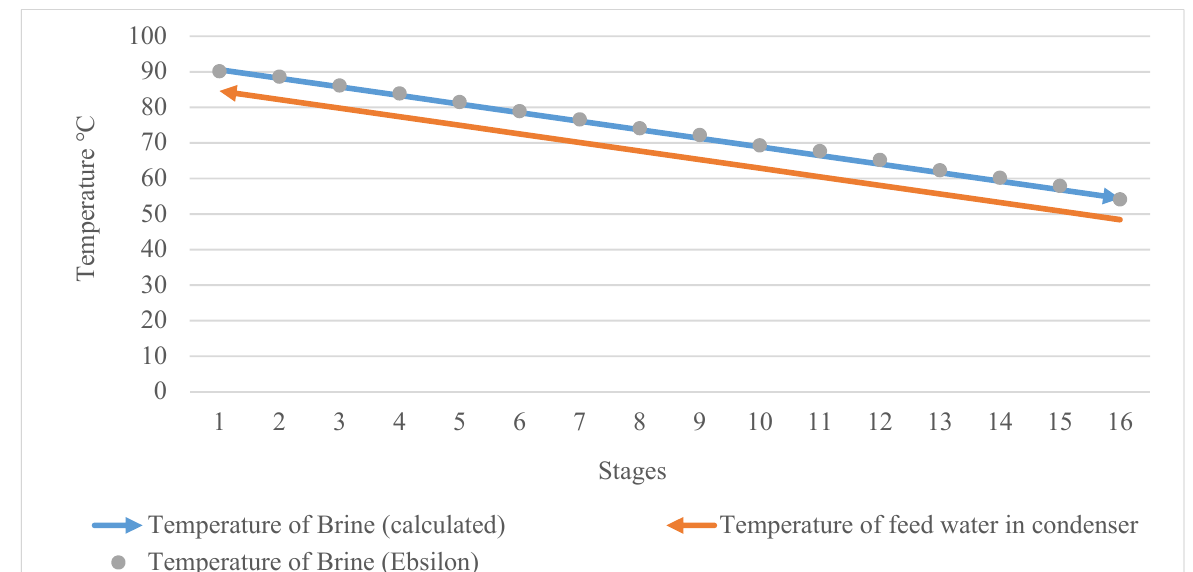
Figure 6. Temperature distributions of feed water in condenser and brine zones.